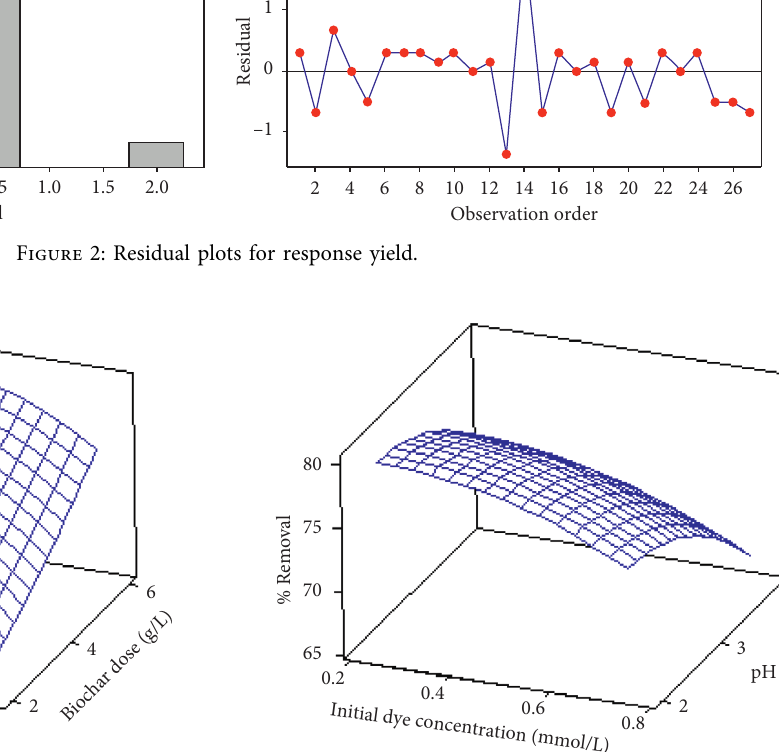
Figure 4: Effect of initial dye concentration (mmol/L) and